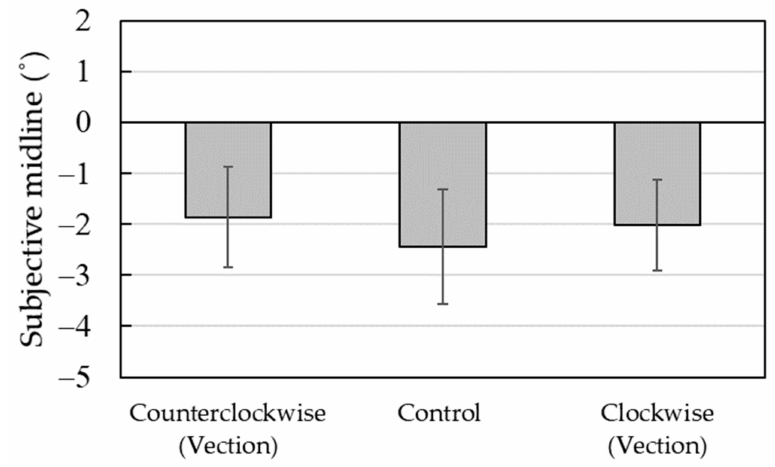
Figure 2. Average subjective midline and standard errors.